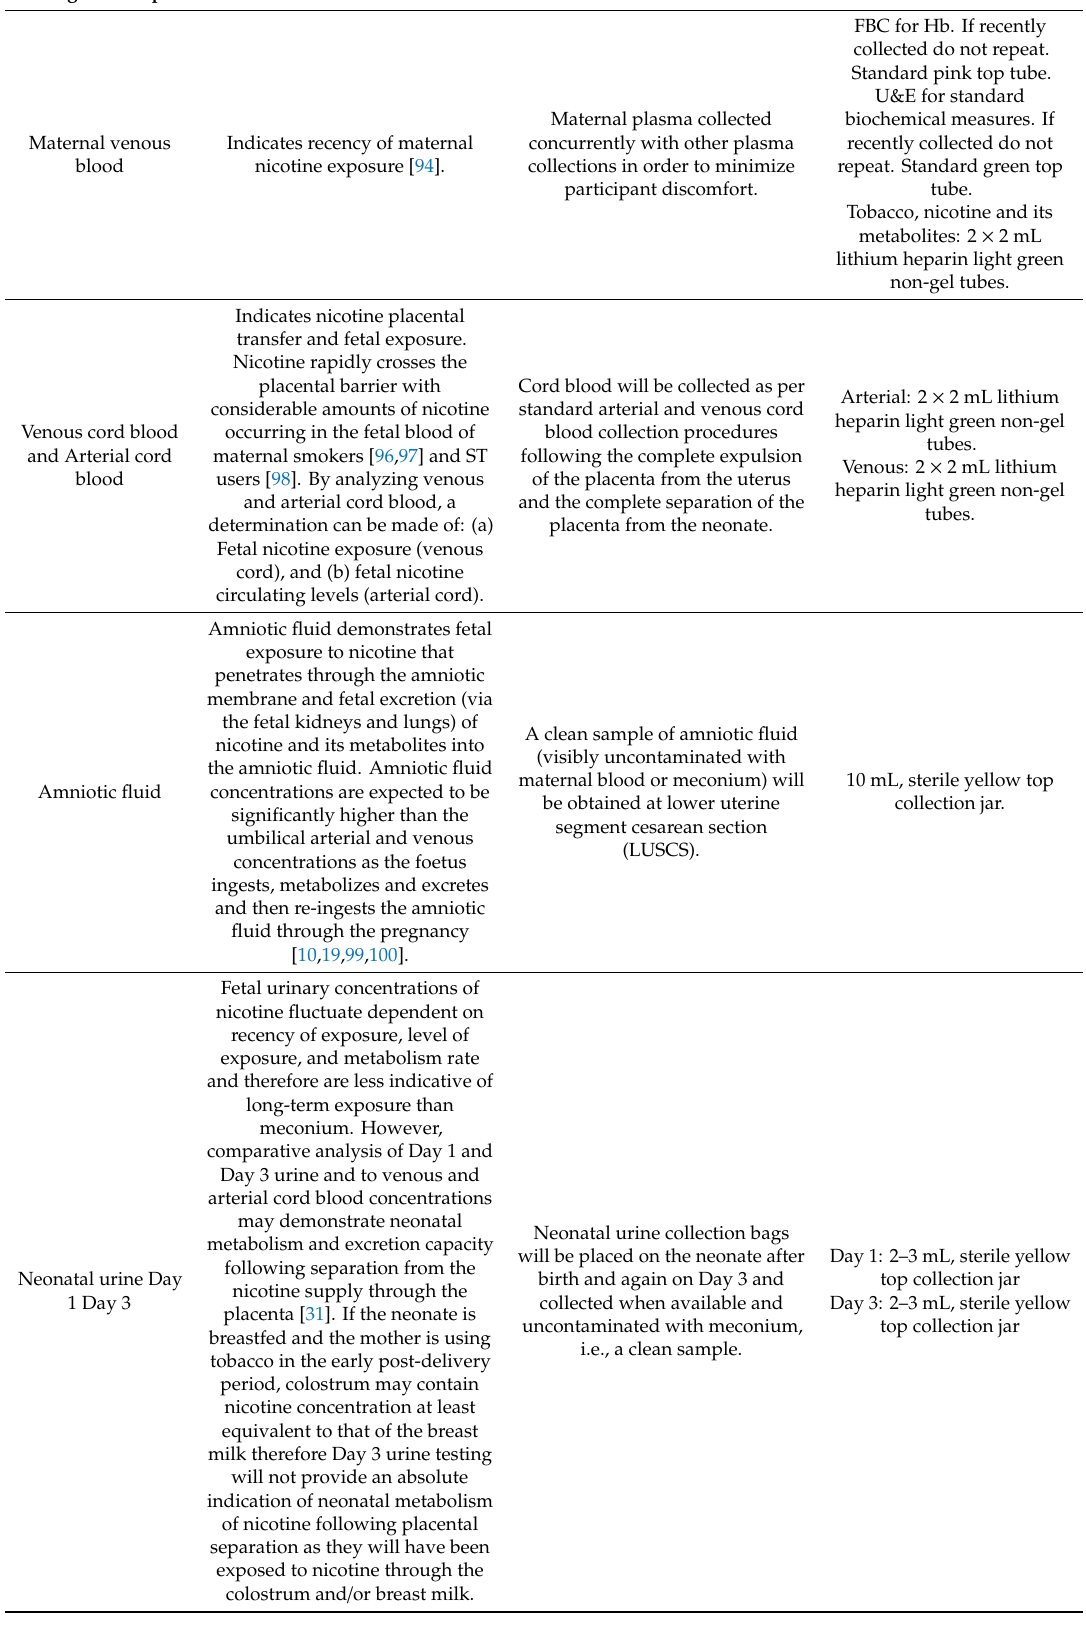
Table 3. Biological sample, rationale for collection and collection